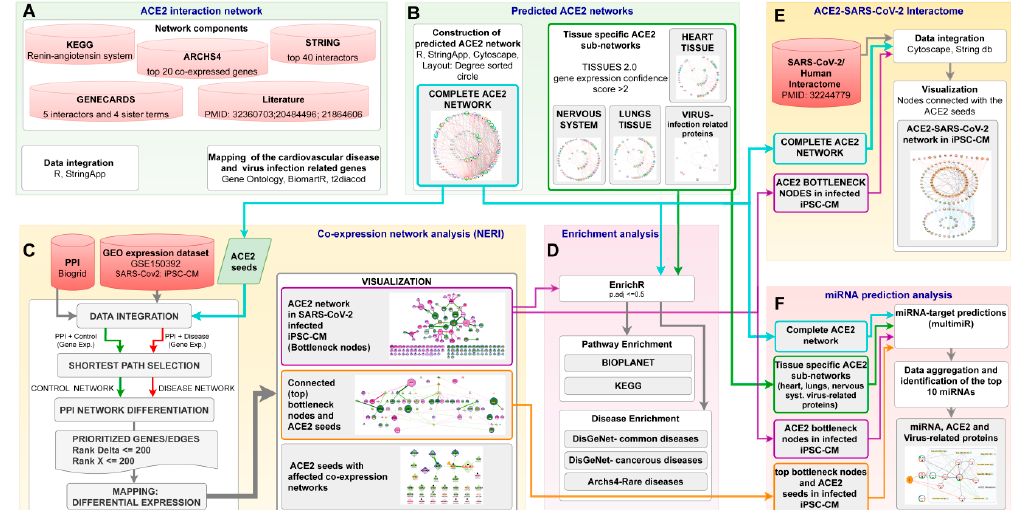
Figure 2. The workflow of bioinformatic analyses. ( A ) data collection to construct complete ACE2 (Angiotensin-Converting Enzyme 2) network; ( B ) generation of the complete ACE2 network as well as tissue-specific sub-networks; ( C ) ACE2-related co-expression network analysis of human-induced pluripotent stem cell-derived cardiomyocyte (hiPSC-CMs) 72 h post-infection with SARS-CoV2 using Network by Relative Importance (NERI) algorithm; ( D ) Enrichment analysis of signaling pathways and diseases related to alterations in ACE2 networks; ( E ) integration of complete ACE2 network with NERI; and ( F ) miRNA prediction analysis in ACE2 related